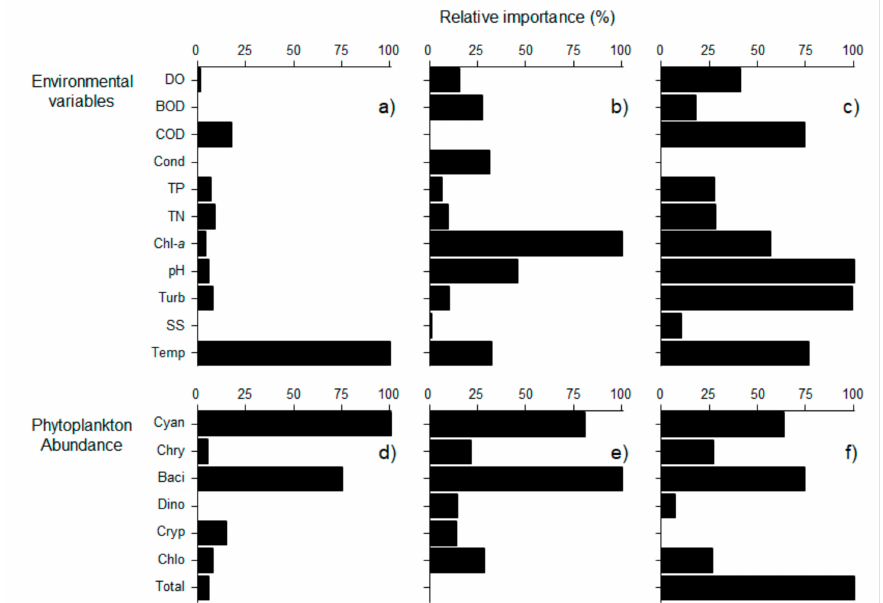
Figure 6. Relative importance (%) of environmental variables ( a – c ) and phytoplankton abundance ( d – f ) in predicting the four categories (A–D) of geosmin concentration in three different depths. Surface layer ( a , d ), Middle layer ( b , e ), and Bottom layer ( c , f ). Abbreviation of each variable indicated in Table 2.